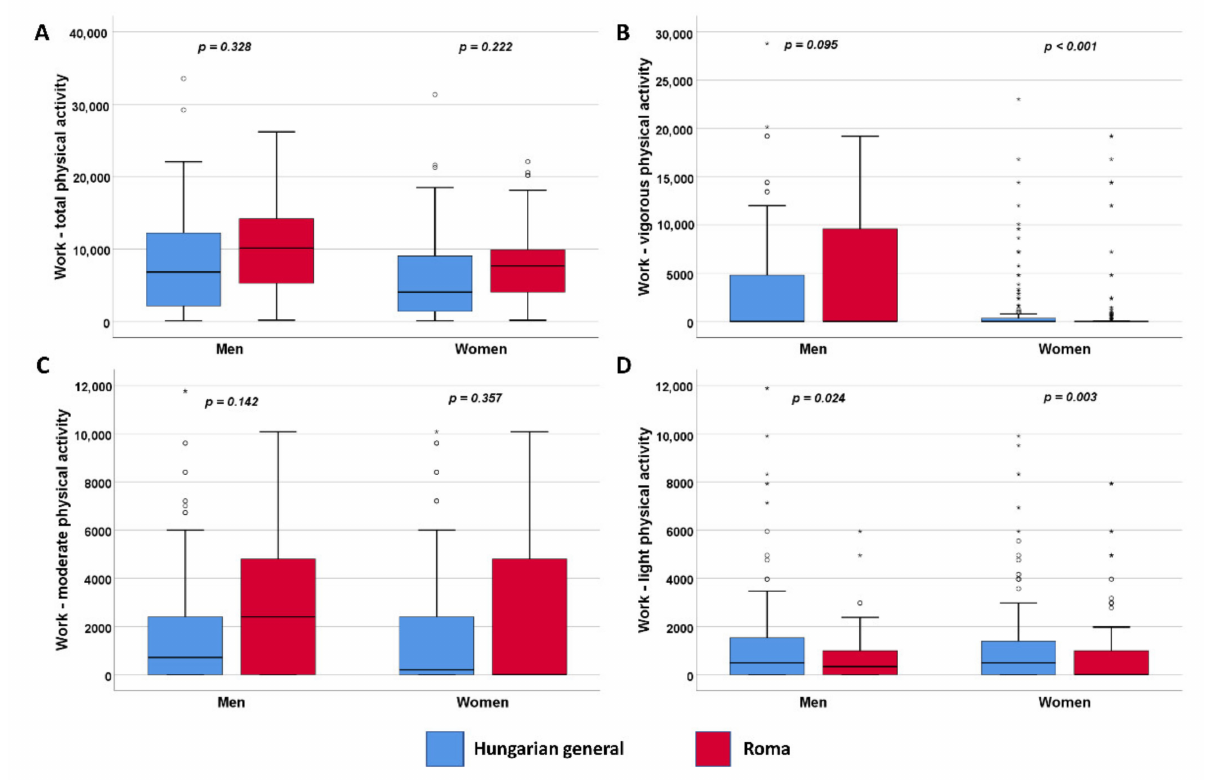
Figure 1. Distribution of physical activity in work ( A ) by intensity ( B – D ) expressed in METs. ◦ : mild outlier data points; *: extreme outlier data points.